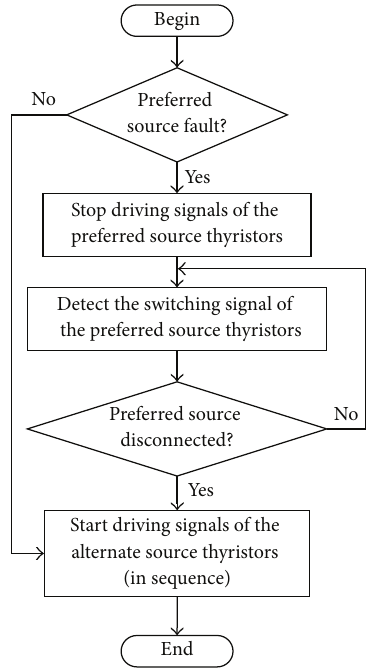
Figure 2: Control flowchart of the transfer